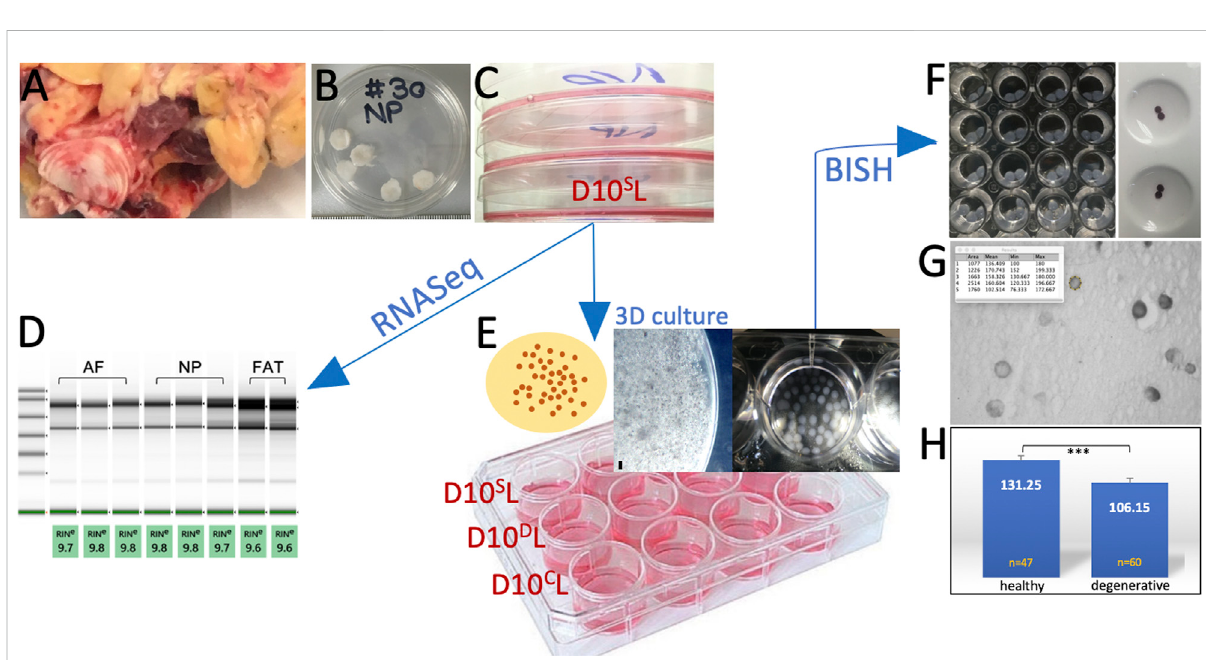
FIGURE 2 Experimental work fl ow showing the bovine tail as cell source (A) . Nucleus pulposus (NP) explants in 1X PBS prior to cell isolation (B) . Initial primary cell expansion in monolayer culture (C) . Transcriptome analysis through RNASeq after RNA quality assessment (D) . Cells were embedded in alginate for 3D culture as shown in the schematic. A high-magni fi cation image of such a bead is shown next to beads collected in a 24-well plate (E) understandard(D10 S L),degenerate(D10 D L),andchondrogenic(D10 C L)conditions.PhenotypingwascarriedoutbyRNA insitu hybridizationon beads (BISH) (F) . Beads were sectioned (G) and submitted to ImageJ analysis (H)